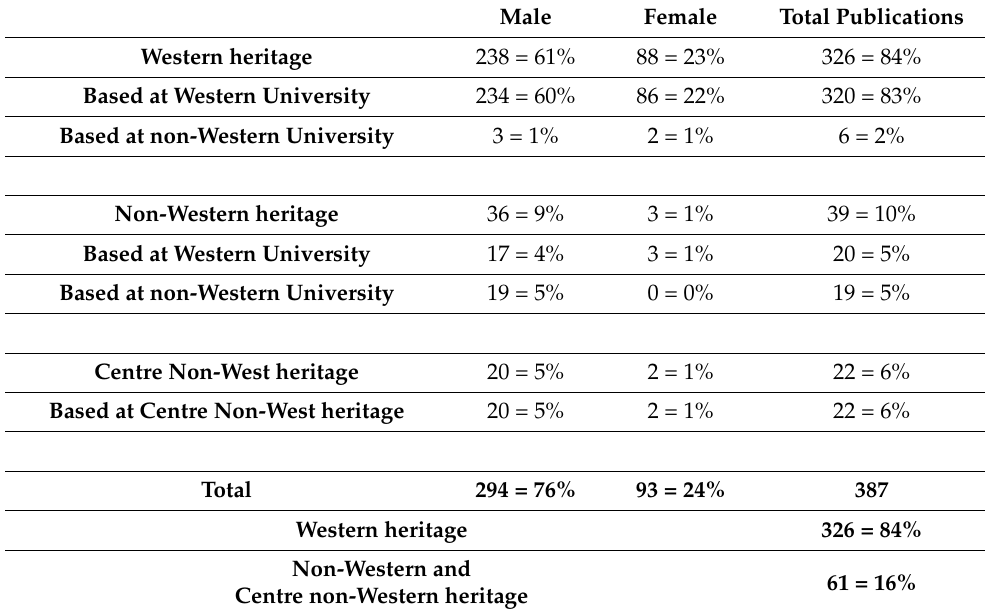
Table A4. Terrorism and political violence.